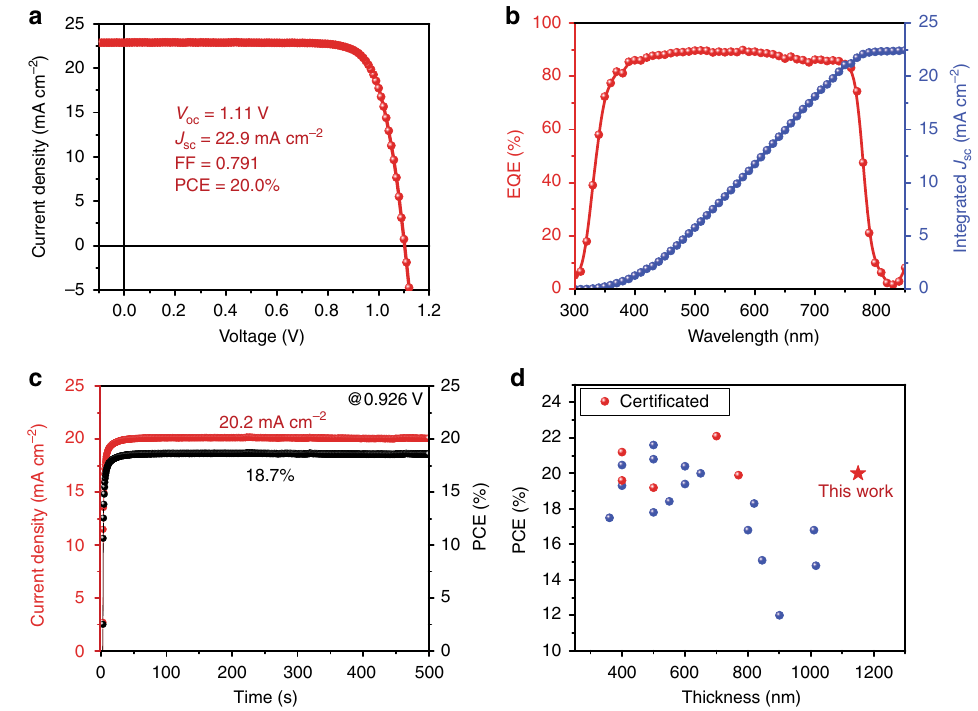
Fig. 3 Photovoltaic performance. a Current density – voltage ( J − V ) curve for the best performing PSC with AM 1.5 radiation under ambient condition. b External quantum ef fi ciency (EQE) spectrum and integrated J SC for perovskite solar cells based on the 1.1- μ m-thick MAPbI 3 (Cl) fi lms. c Stabilized photocurrent density output by holding the voltage at the maximum power point (0.926 V) for PSCs based on 1.1- μ m-thick MAPbI 3 (Cl) fi lms. d Comparison of the PSCs and the corresponding perovskite fi lm thickness in the representative reports and this work (Supplementary Table